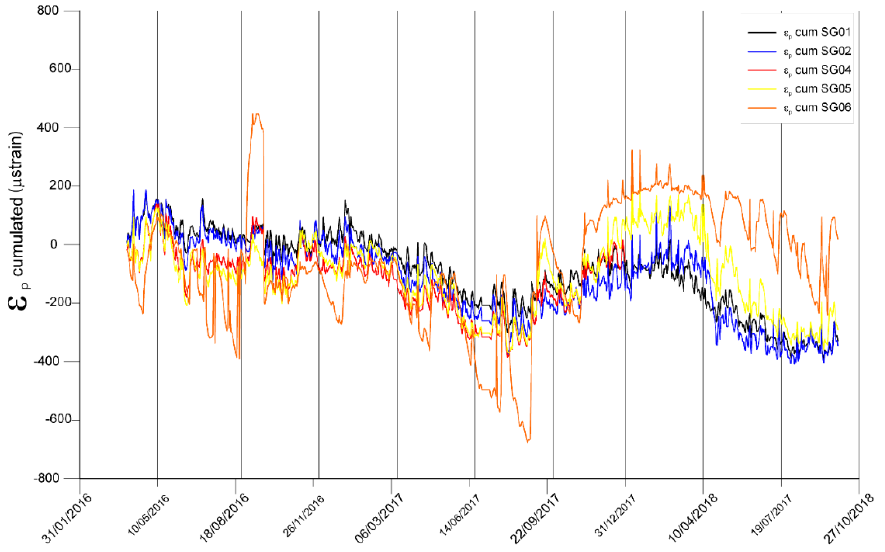
Figure 11. Net deformation value ( ε p ), daily cumulated for each strain